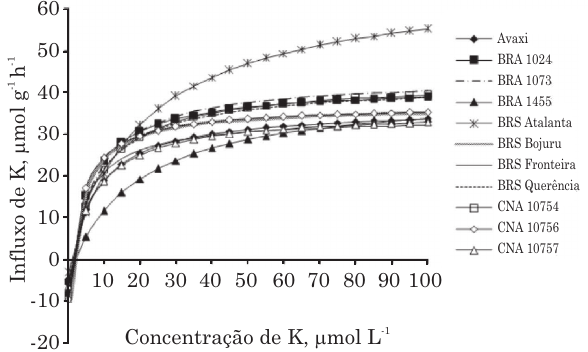
Figura 2. Influxo de potássio em função da concentração de K na solução de 11 genótipos de arroz